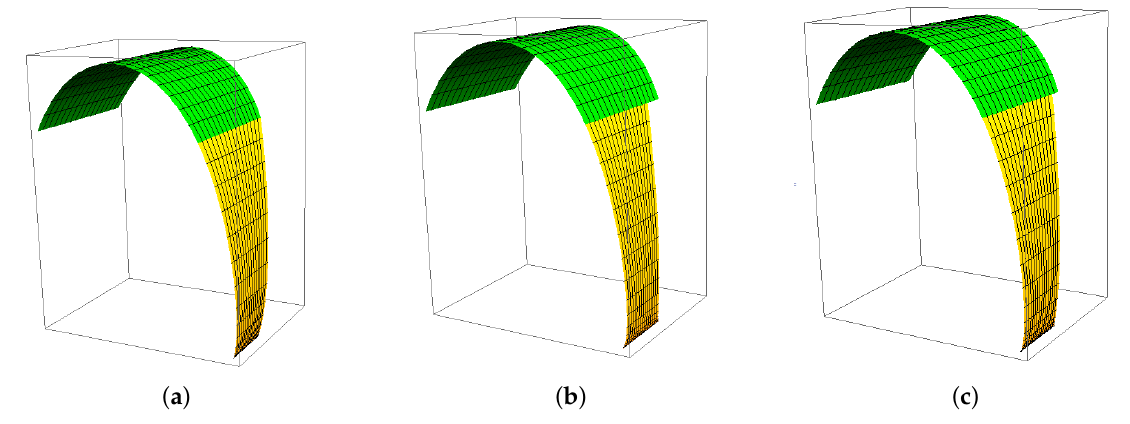
Figure 10. Beta G 2 continuity of developable GHT-Bézier